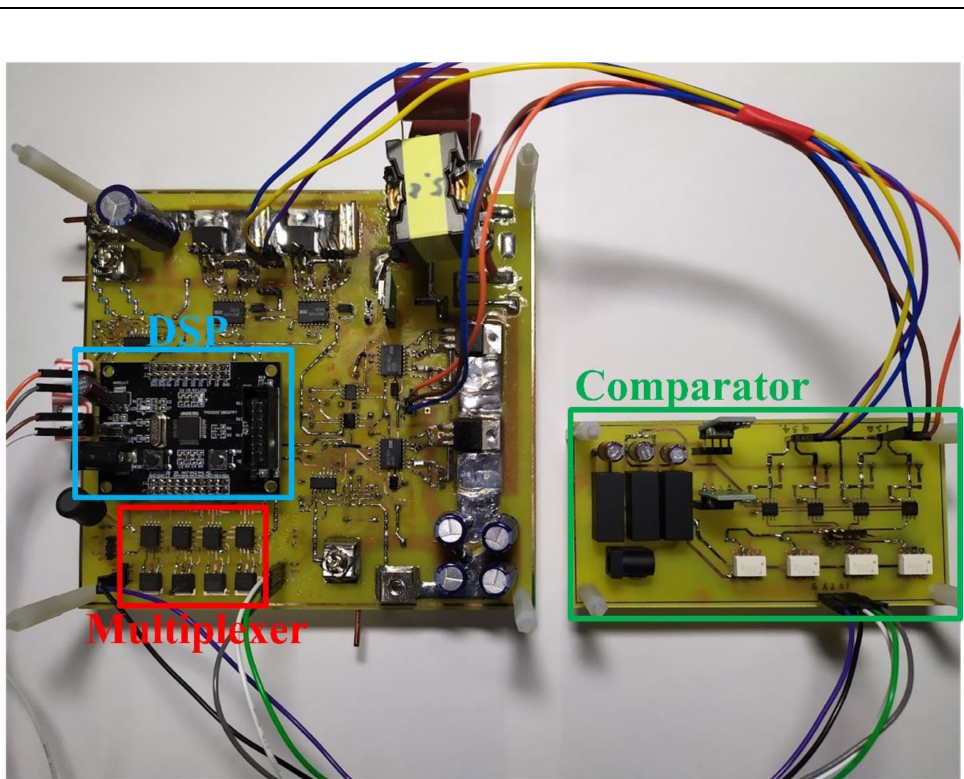
Figure 16. Photograph of the proposed